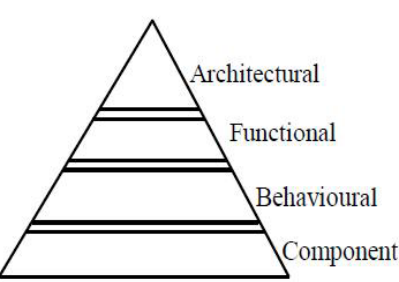
Figure 7. Four layer